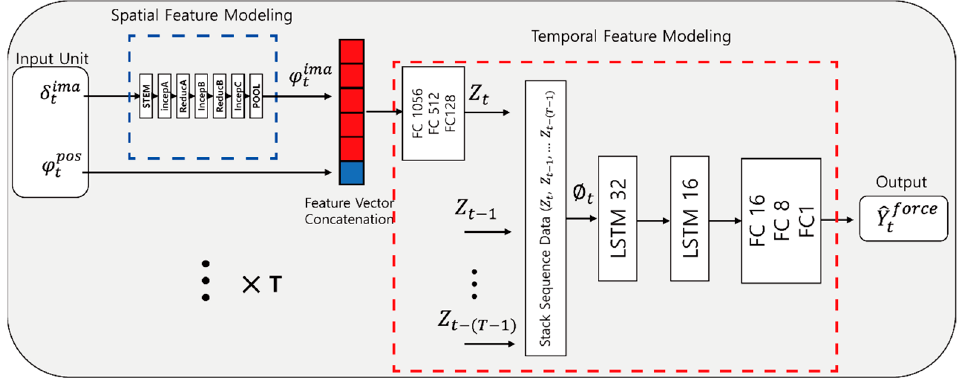
Figure 5. Proposed network structure. The network consists of spatial feature modeling and temporal feature modeling. Whereas spatial feature modeling and temporal feature modeling are trained separately, the two models trained are used together for the suture tensile force estimation during the test stage. Preprocessed images and preprocessed tool positions are used as input for the suture tensile force estimation. 𝛿 (cid:3047)(cid:3036)(cid:3040)(cid:3028) ∈ 𝑅 (cid:2871)(cid:2870)(cid:2868)(cid:3400)(cid:2870)(cid:2872)(cid:2868)(cid:3400)(cid:2871) = preprocessed image, 𝜑 (cid:3047)(cid:3036)(cid:3040)(cid:3028) ∈ 𝑅 (cid:2869)(cid:2873)(cid:2871)(cid:2874) = feature vectors from the image, 𝜑 (cid:3047)(cid:3043)(cid:3042)(cid:3046) ∈ 𝑅 (cid:2871) = preprocessed tool position, and 𝑍 (cid:3047) ∈ 𝑅 (cid:2869)(cid:2870)(cid:2876) = FC output feature of the feature vector concatenation. The feature vector concatenation is a concatenation of the image feature and tool position, ∅ (cid:3047) ∈ 𝑅 (cid:3021)(cid:3400)(cid:2869)(cid:2870)(cid:2876) = stacked sequence feature vector, 𝑌(cid:3552) (cid:3047)(cid:3033)(cid:3042)(cid:3045)(cid:3030)(cid:3032) ∈ 𝑅 (cid:2869) = estimated suture tensile force, and T = sequence size.